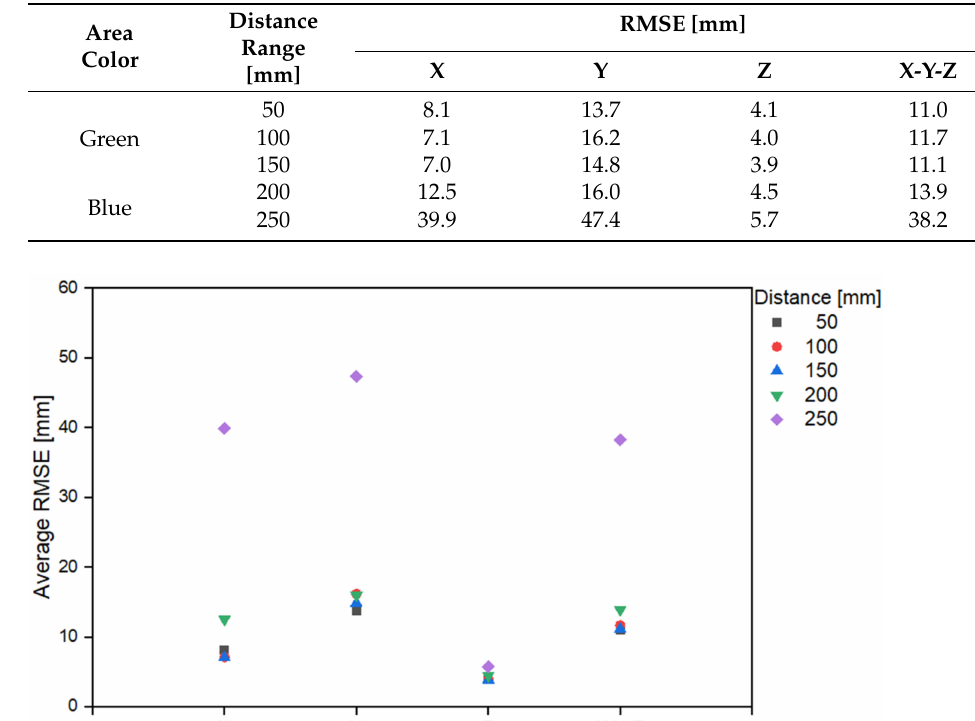
Figure 9. RMSE graph based on the X-Y distance.